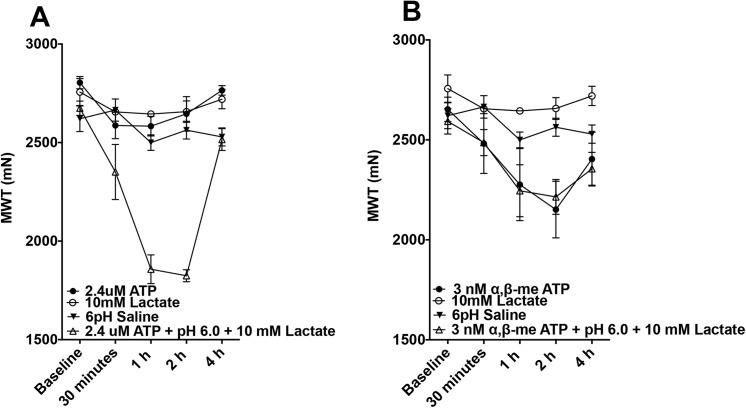
Comparison of Individual Components Versus Combined Solution on muscle withdrawal thresholds across a 4h time period.(A) Injection of protons, lactate, and ATP alone compared to the combined solution. Muscle withdrawal threshold was measured before and after intramuscular injection with pH 6 saline (n = 4), 10 mM lactate (n = 4), 2.4 μM ATP (n = 4), and all three in combination (n = 5). None of the individual components had an effect on muscle withdrawal threshold, but the combination produced significant decreases (Repeated measures ANOVA, F3,13 = 54.568, p < 0.001, Tukey test, p < 0.05 for each compound alone). (B) Injection of protons, lactate, and α,β–meATP alone compared to the combined solution. Muscle withdrawal threshold was measured after intramuscular injection with pH 6 saline (n = 4), 10 mM lactate (n = 4), 3 nM α,β–meATP (n = 4), or all three in combination (n = 6). The 3 nM α,β–meATP and the combination solution produced similar decreases in muscle withdrawal threshold (Repeated-measures ANOVA F3,14 = 5.373, p < 0.011, Tukey test p > 0.05 for 3 nM α,β–meATP compared to combination solutions, p < 0.05 the remaining) *, p < 0.05.